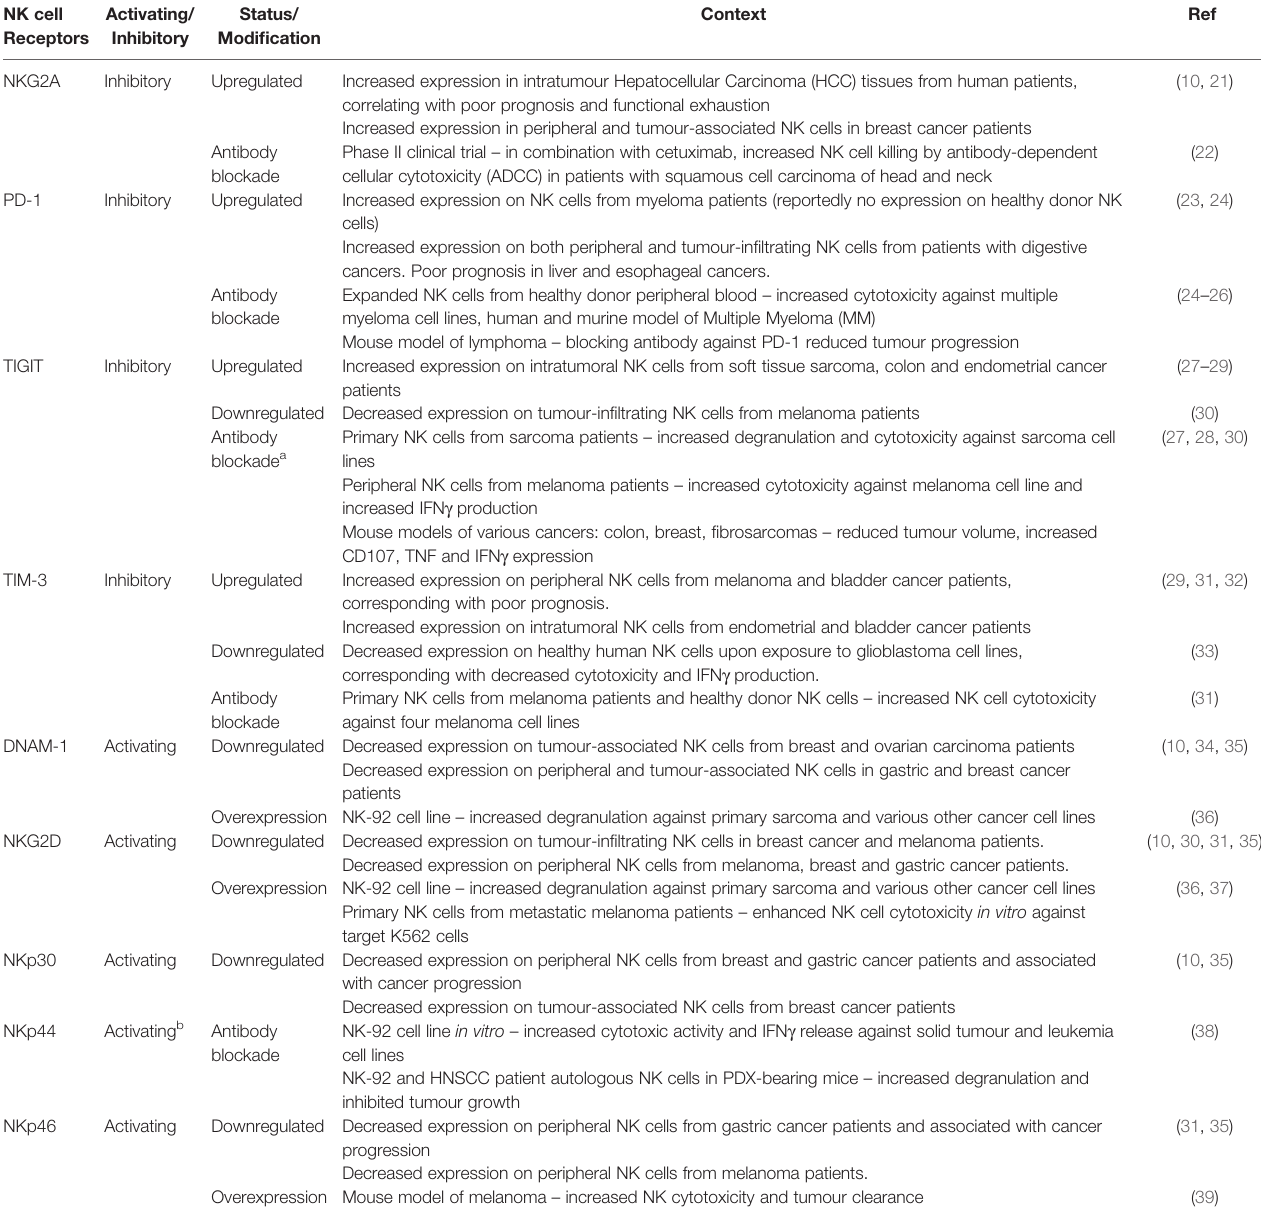
TABLE 1 | Archetypal NK receptors in NK cell function, exhaustion and restoration. NK cell Activating/ Receptors